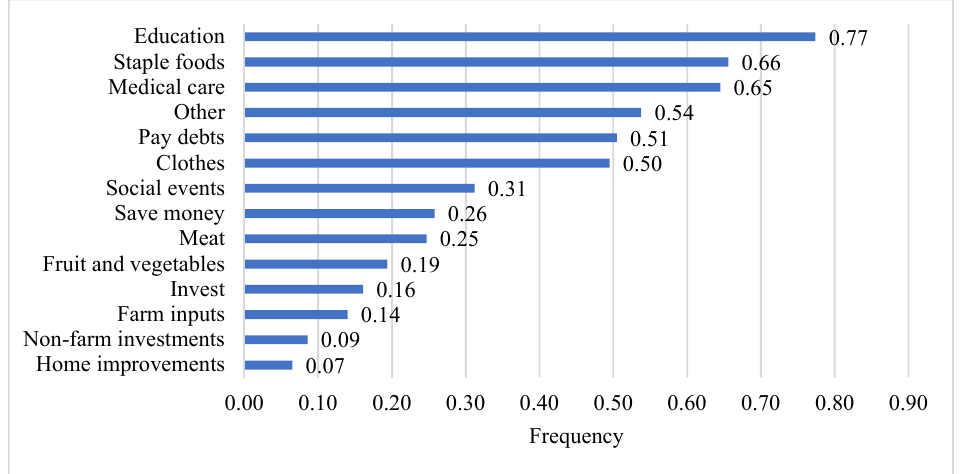
Figure 6. Reported Increases in Spending.